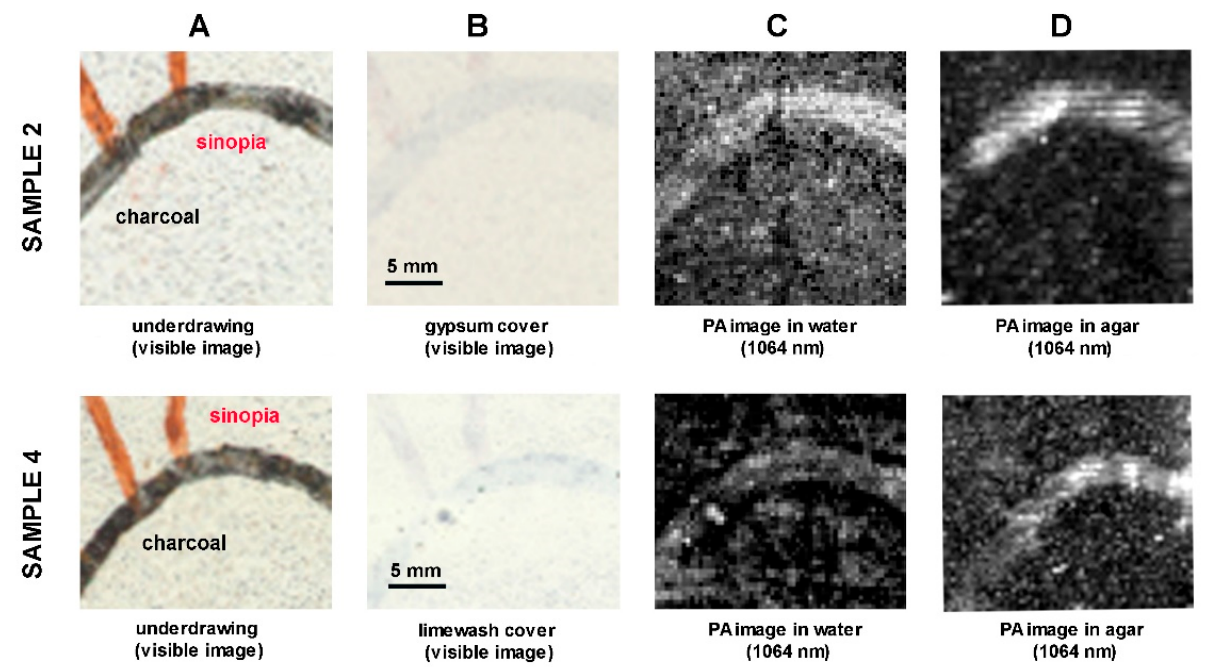
Figure 3. Reflectance PA imaging results on graphite and charcoal underdrawings ( A ) hidden under Egyptian blue tempera paint ( B ); comparison of results in water ( C ) and agar ( D ). The red arrow indicates the area corresponding to the charcoal outline in a PA image. The scale in 3B is valid for all images in the row.